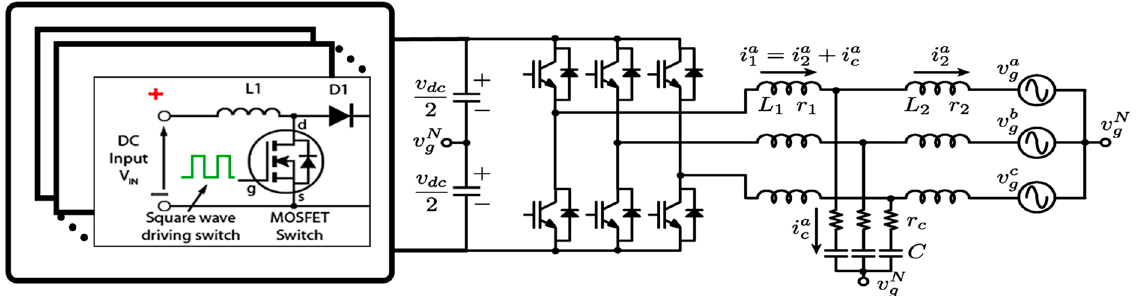
Figure 9. Different components of the grid-connected photovoltaic system.